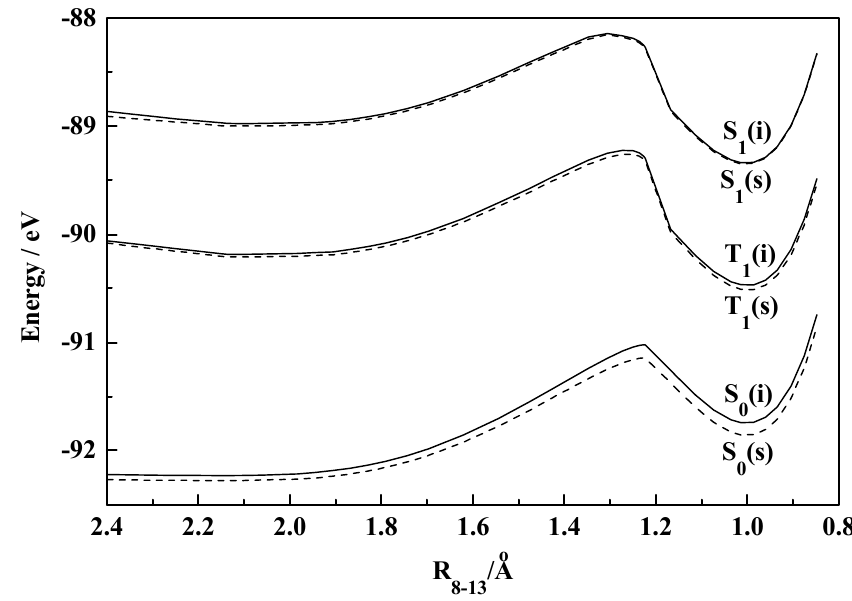
Figure 12. Simulated PECs for IPT process of HPT in S